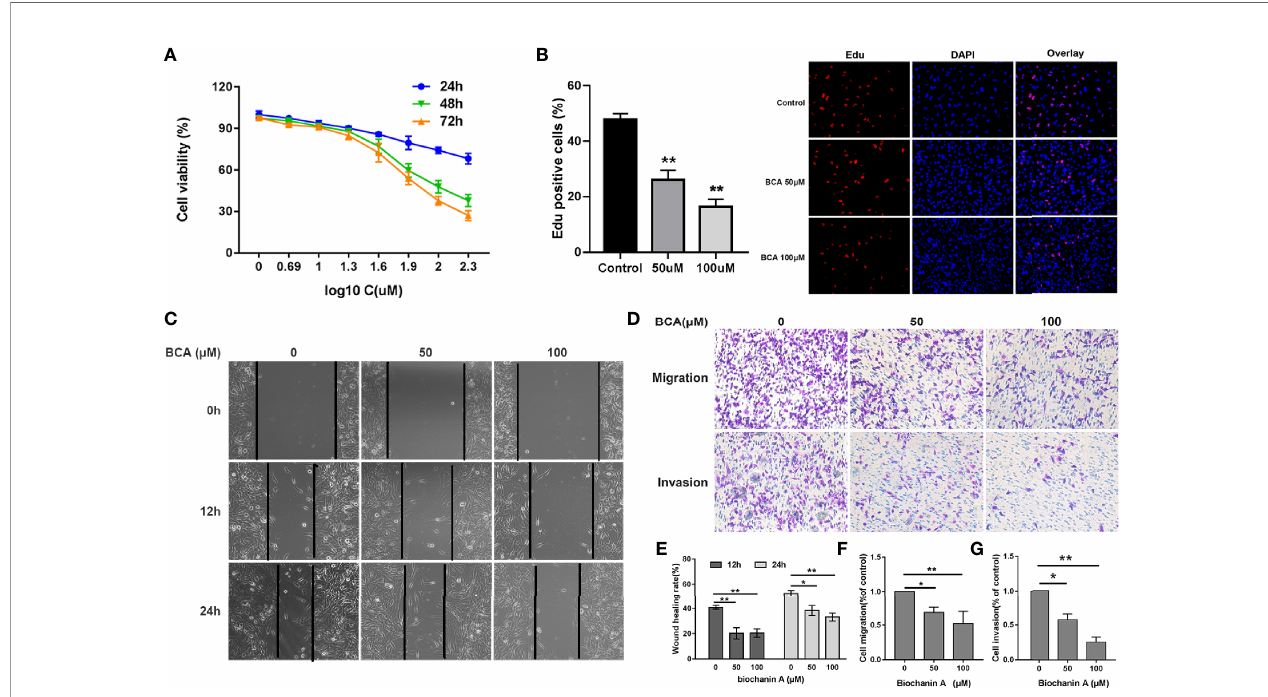
FIGURE 1 | BCA inhibited the proliferation, migration, and invasion of U251 cells. (A) U251 cells were treated with various concentrations of BCA for 24, 48, and 72 h. Cell proliferation was measured by CCK8 assay. (B) Cellular proliferation was measured via an Edu assay. (C) Wound healing assay shows the migrated cells at 0, 12, and 24 h after treatment with BCA (0, 50, and 100 m M). (D) After treatment, the transwell assay showed that the migration and invasion cells at 24 h. (E) Quanti fi cation of the wound healing rate in A after treatment with BCA. (F, G) Quanti fi cation of the migration and invasion cells. ( ∗ ) p < 0.05 and ( ∗∗ ) p < 0.01 for Student ’ s t